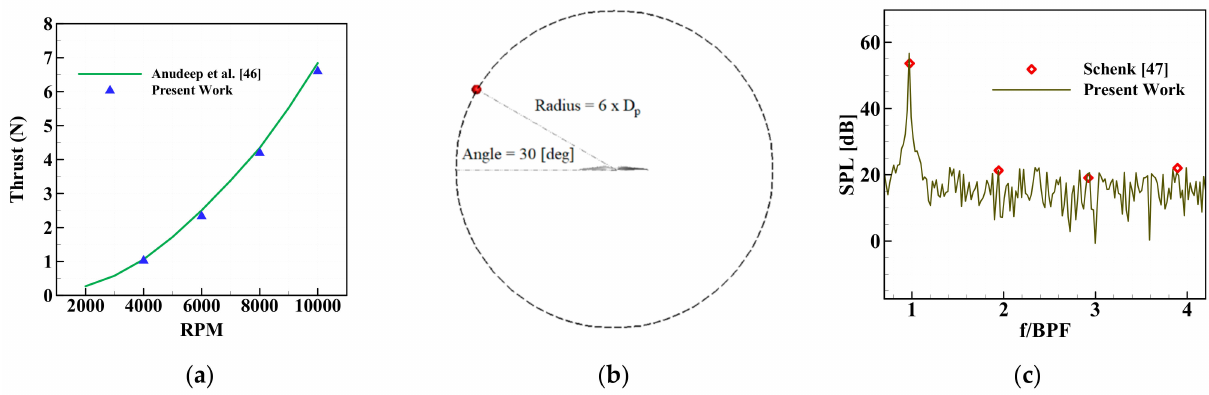
Figure 6. Validation: ( a ) Thrust for CRC-3 propeller; ( b ) position of the microphone in acoustics validation simulation; ( c ) SPL spectrum for APC 10 × 7E at RPM = 4660 and static